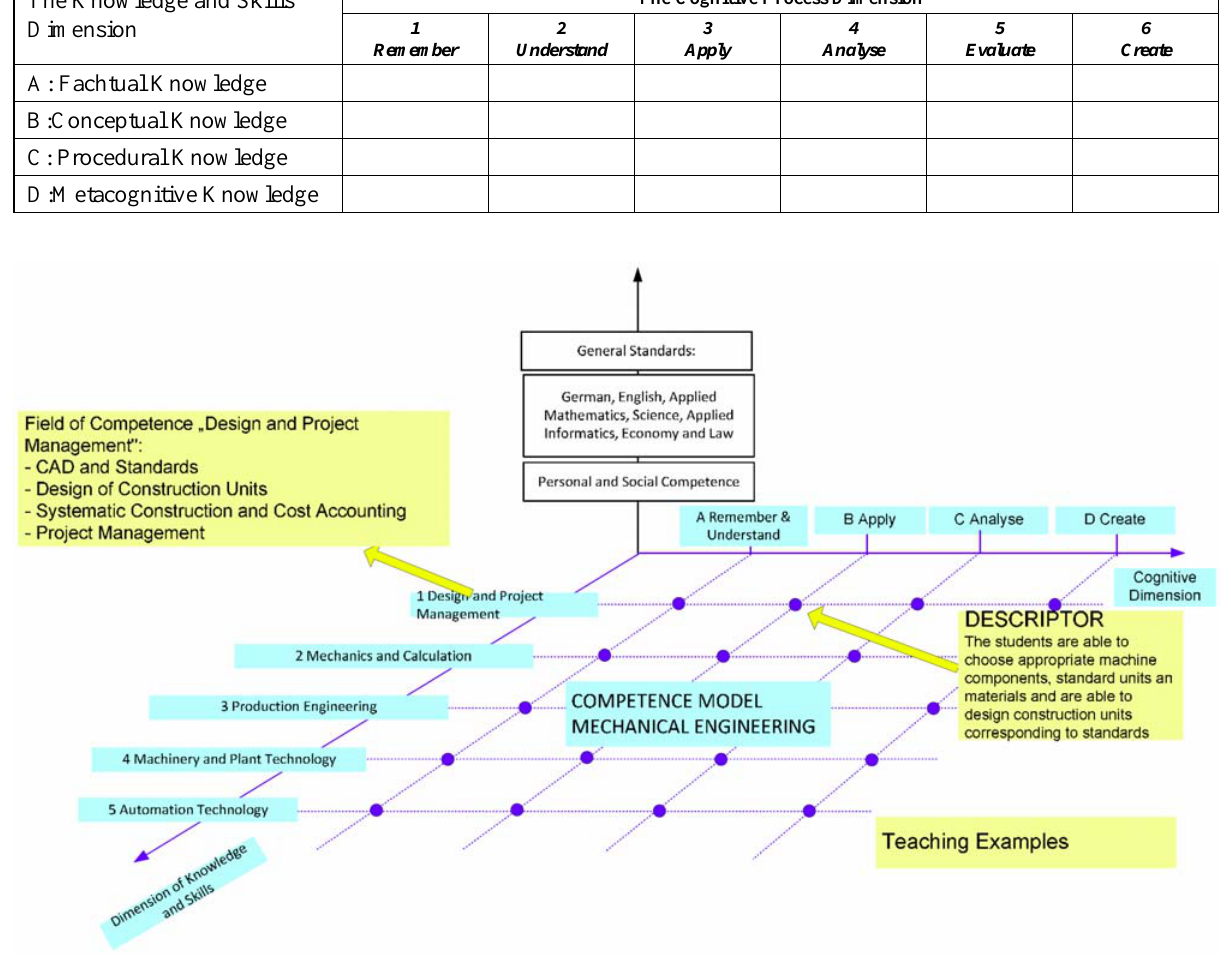
Figure 1. Based on the above-mentioned descriptions, Austria has developed its own